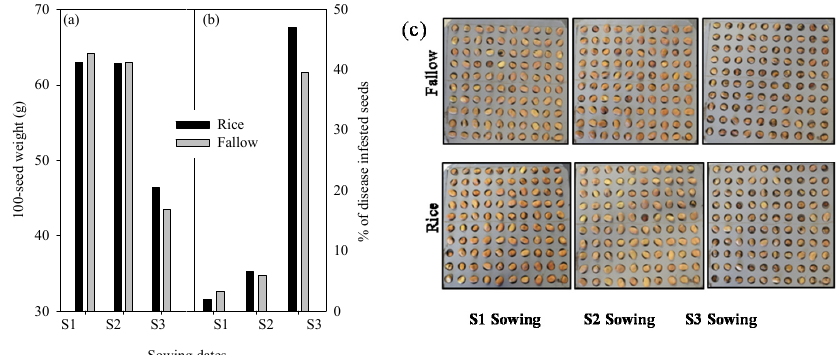
Figure 7. Weed dry weight ( a ), ( b ) and grain yield loss ( c ), ( d ) in post ‐ rice and post ‐ fallow pea ( a ), ( c ) and faba bean ( b ), ( d ) at three sowing dates (S1, S2 and S3). Error bars projecting from shaded vertical bars represent the standard deviation of the mean ( n = 4). Error bars in the lower left corners of Panels ( c ) and ( d ) indicate LSD values at the 5% level of significance. The values in parentheses represent grain yield losses in non ‐ weeded plots (LSD 0.05 = 25 for field pea and 92 for faba bean).